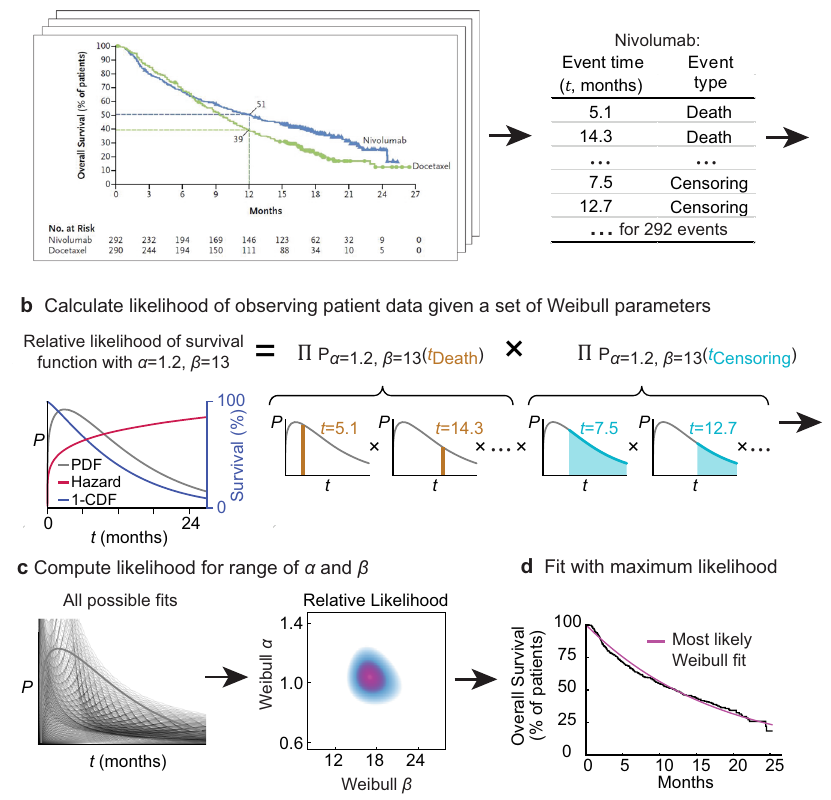
Fig. 1 Procedure for parameterizing survival curves starting with published fi gures. a Kaplan – Meier survival curve and at-risk table obtained from clinical trial publication. Individual participant data (IPD) were imputed from digitized survival curves and at-risk tables as previously described (see “ Methods ” ). b Each set of parameters corresponds to a different probability density function (PDF) and survival function (which corresponds to 1 minus the cumulative density function (CDF)). The likelihood of observing actual data is then computed. c Likelihood calculation is repeated for a set of possible parameter values. d The most likely (best) fi t is obtained by fi nding the parameter values with the maximum